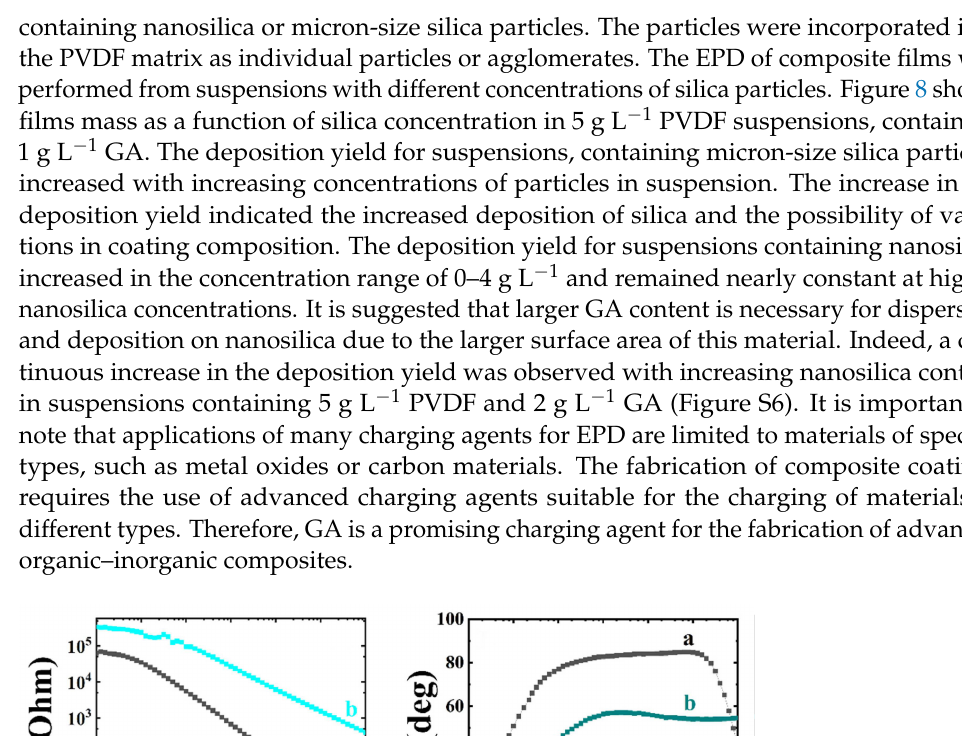
Figure 6. Bode plots for ( a ) uncoated substrate and ( b ) coated from 5 g L − 1 PVDF suspensions con- taining 1 g L − 1 GA and annealed at 200 °C. PVDF films were obtained at deposition time of 5 min containing 1 g L − 1 GA and annealed at 200 ◦ C. PVDF films were obtained at deposition time of 5 min and deposition voltage of 100 V. and deposition voltage of 100 V.